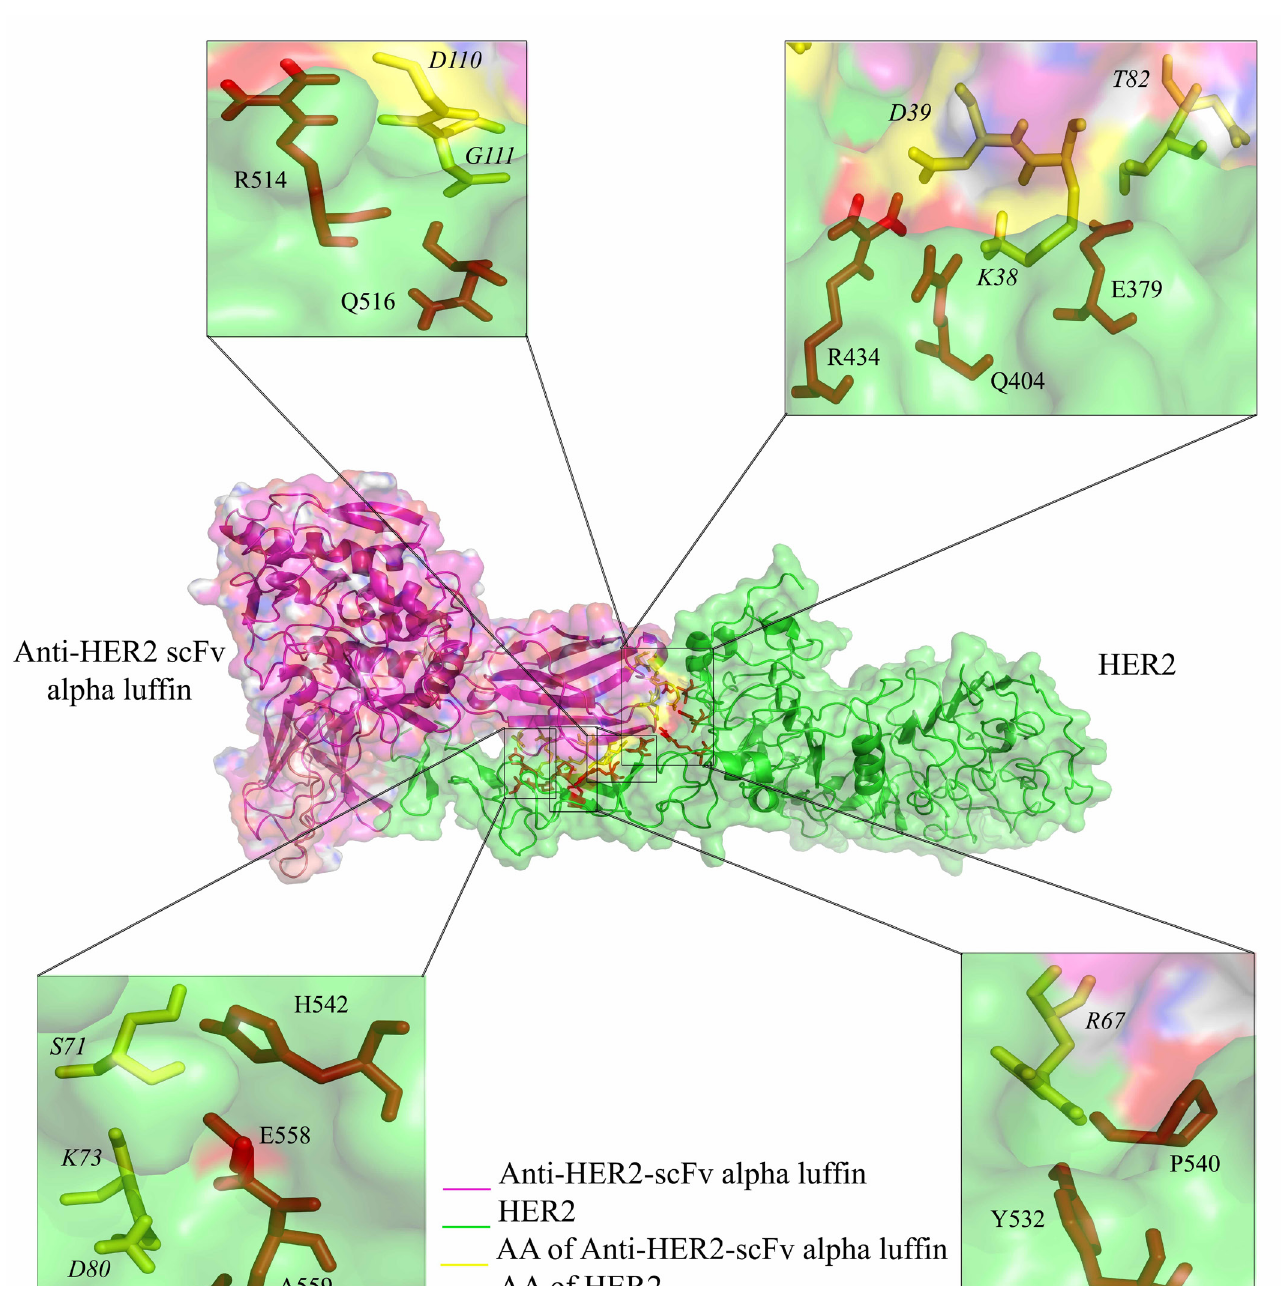
FIGURE 5 - Binding model of the fusion protein with the extracellular domain of HER2 protein. Surface-cartoon representation of complex is shown in in magenta and green for the fusion protein and HER2, respectively. Close-up view of the stick representation of amino acid residues involved in the interaction of the fusion protein and HER2 are illustrated in yellow and red,